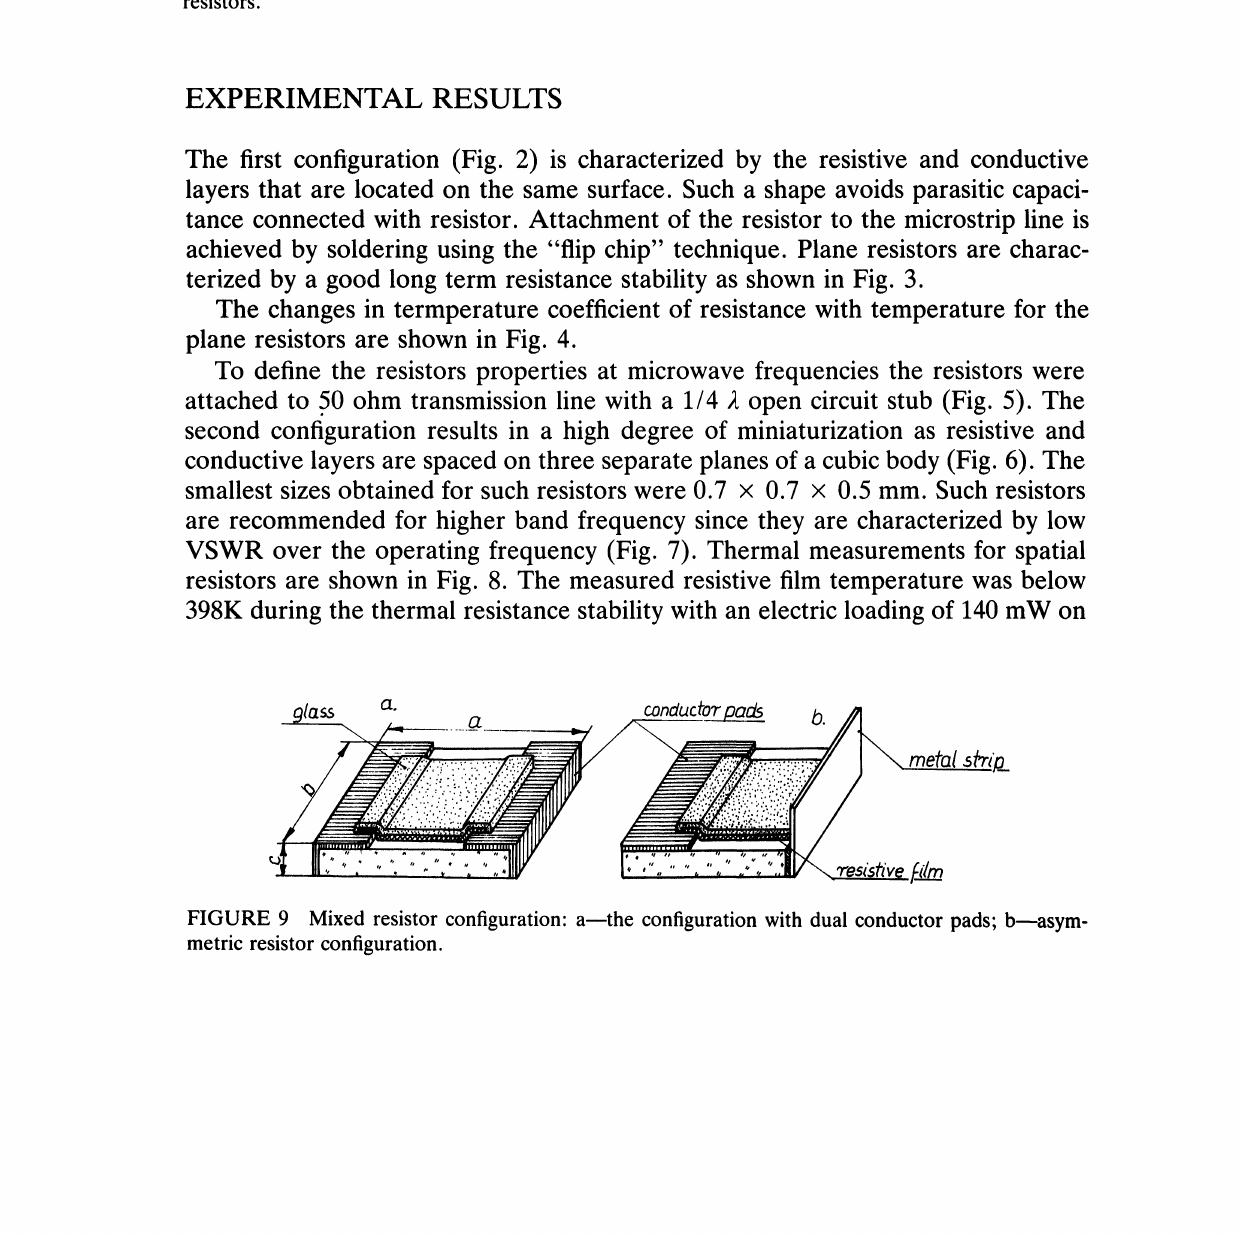
FIGURE 8 Long-term resistance stability and the changes of TCR with temperature for spatial resistors.